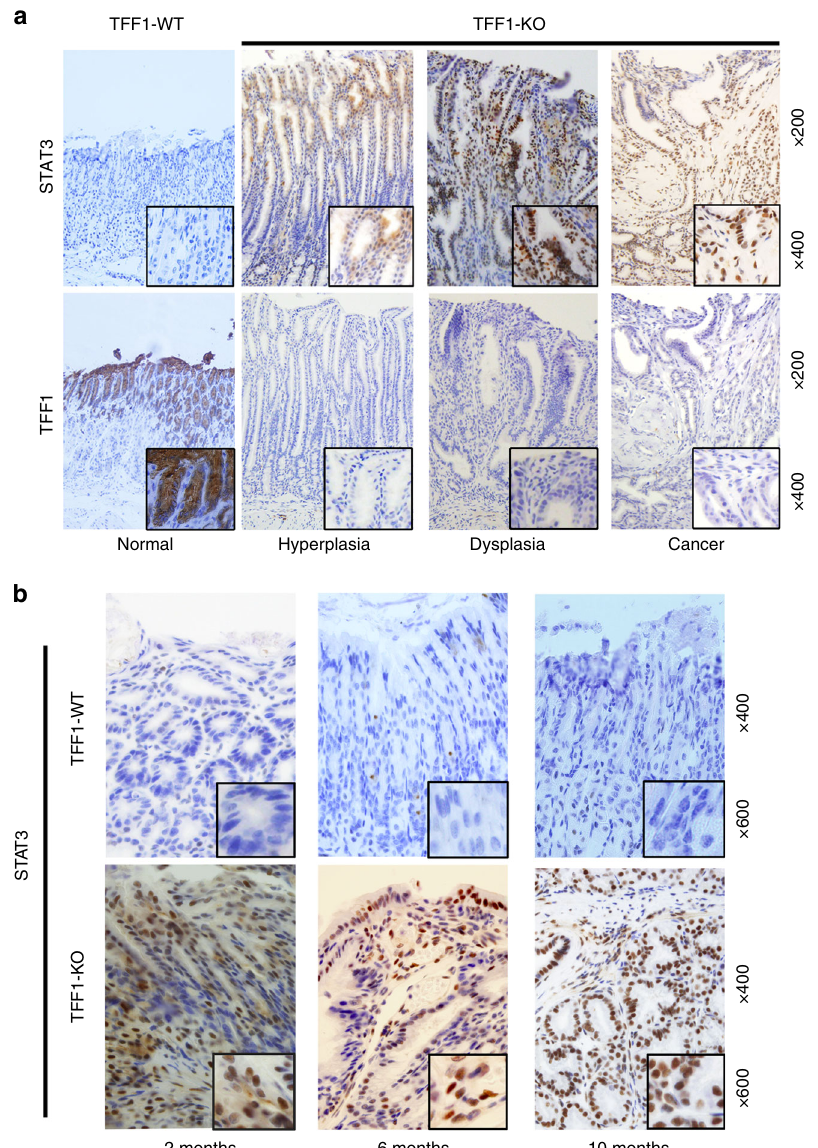
Fig. 1 Loss of TFF1 promotes STAT3 nuclear localization in the TFF1-KO mice gastric tissues. a Representative immunohistochemistry images in the upper panels show nuclear p-STAT3 (Y705) in hyperplasia, dysplasia, and cancer from the antropyloric region of glandular stomach in TFF1-knockout (TFF1 - KO), but not in TFF1 - wild-type (TFF1 - WT) normal gastric mucosa. The lower panels demonstrate the expression of TFF1, original magni fi cation (×200) and insets (×400). b Immunohistochemistry staining of p-STAT3 of gastric mouse tissues from TFF1-WT and TFF1-KO mice at the age of 2, 6, and 10 months detected p-STAT3 in the nucleus at all ages in TFF1-KO mice. p-STAT3 staining was absent in tissues from matched ages in TFF1-WT mice with normal glands. The TFF1-KO mice showed dysplastic lesions at 6 and 10 months of age. Original magni fi cation (×400) and insets cells (Fig. 3a), and in 3D culture of organoids derived from TFF1-KO gastric mouse tissue, as compared to TFF1-WT (Fig. 3b, P < 0.001).